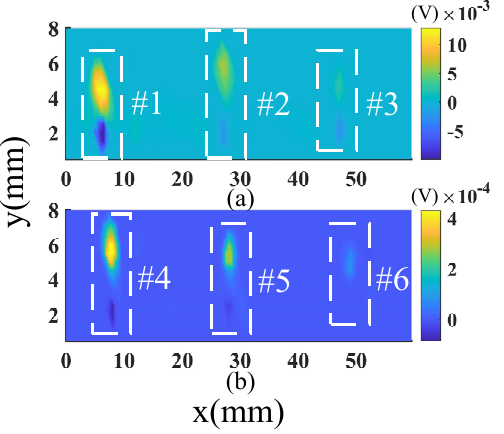
Figure 15. ( a , b ) are the SD mode fused images of defects #1 − #3 and defects #4 − #6, respectively.